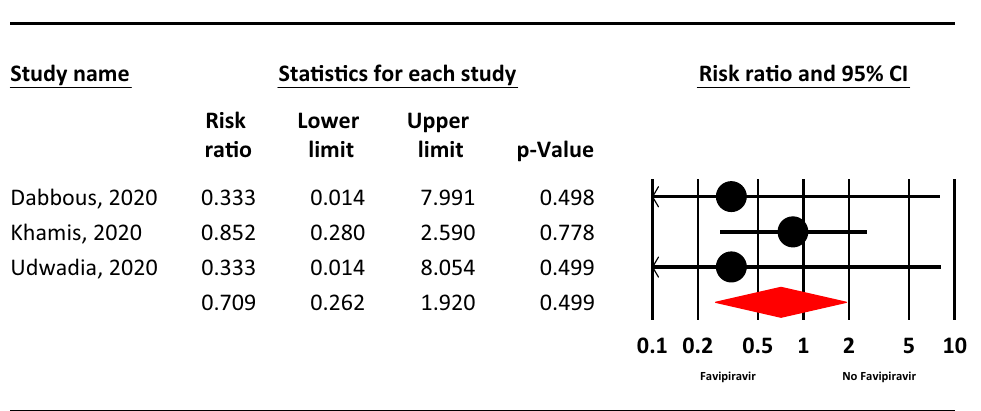
Figure 6. The meta-analysis of transferred to ICU of Favipiravir on COVID-19 patients (red diamond: summery of total).